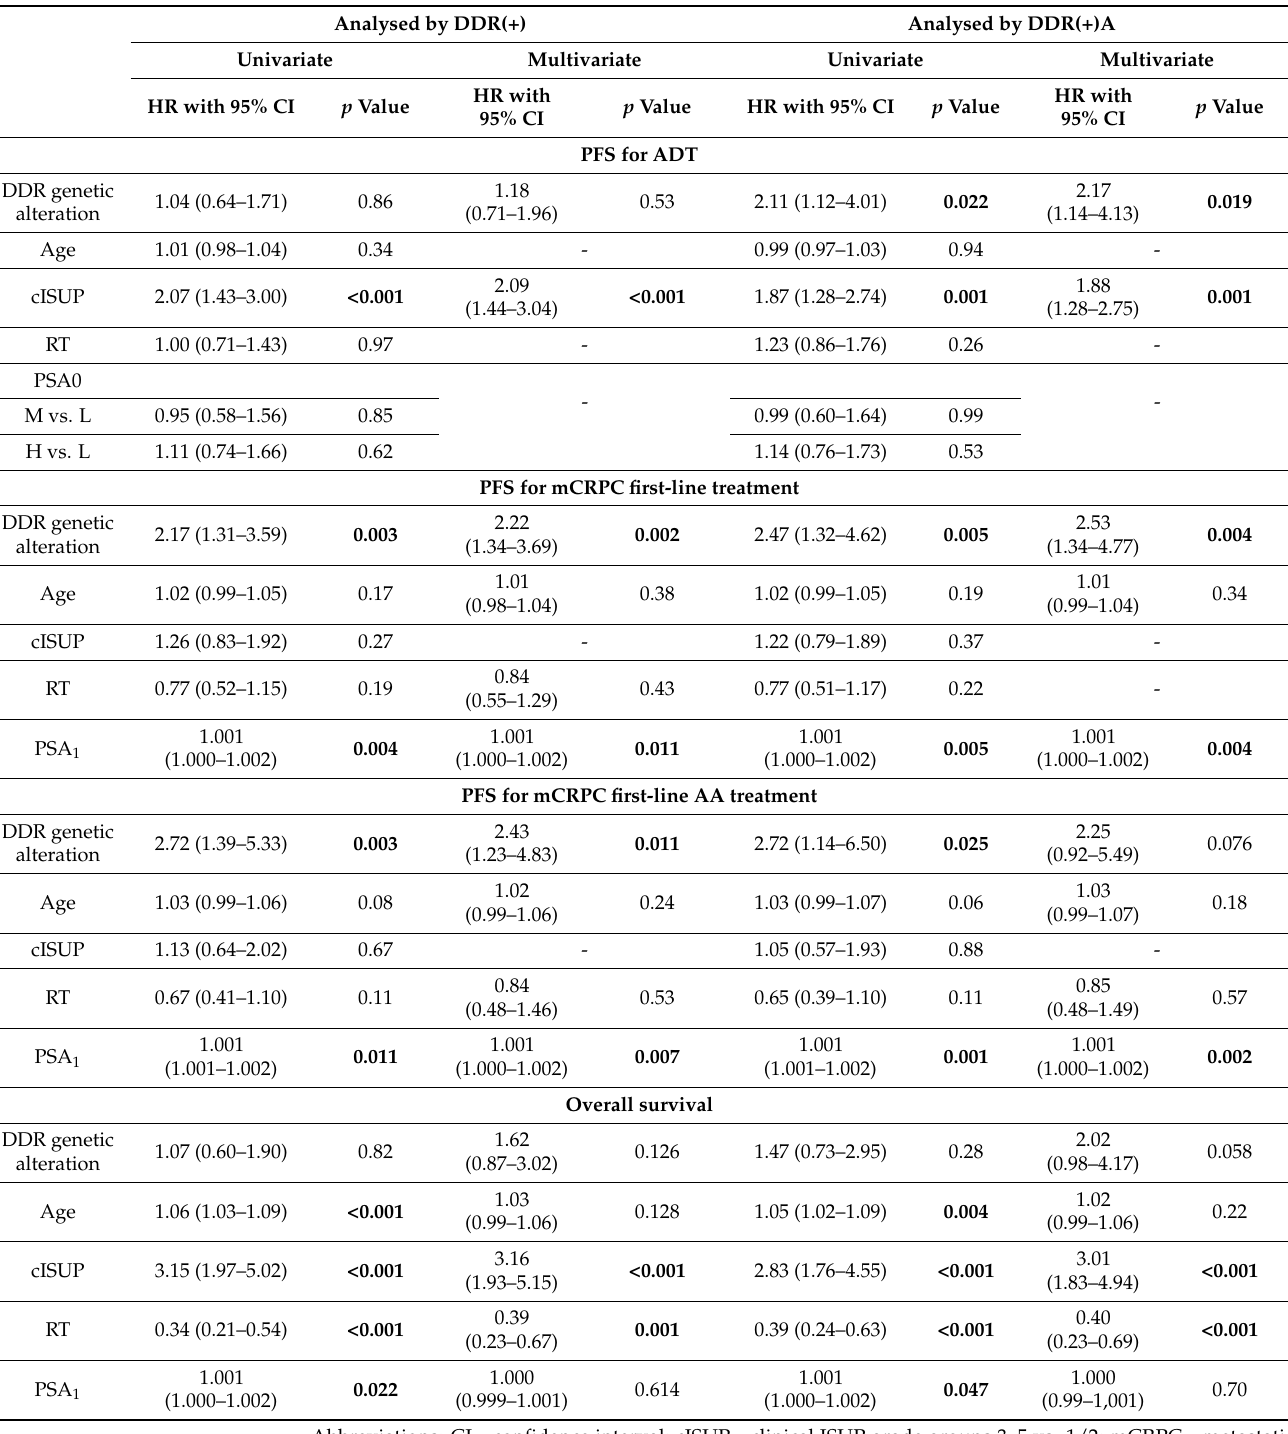
Table 3. Univariate and multivariate Cox regression analysis to assess significant factors associated with treatment and survival